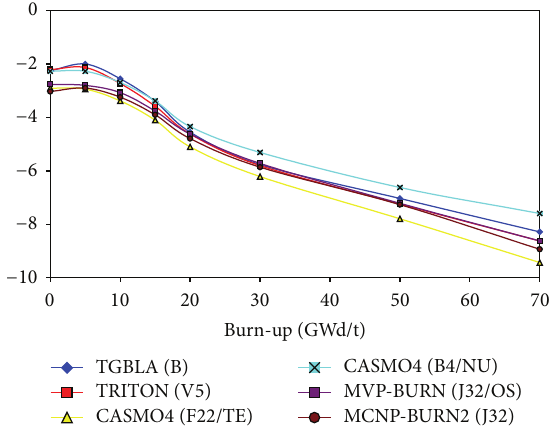
Figure 2: Void reactivity effect (0%–70%) over burn-up for innova- tive assembly with UO 2 fuel [7].